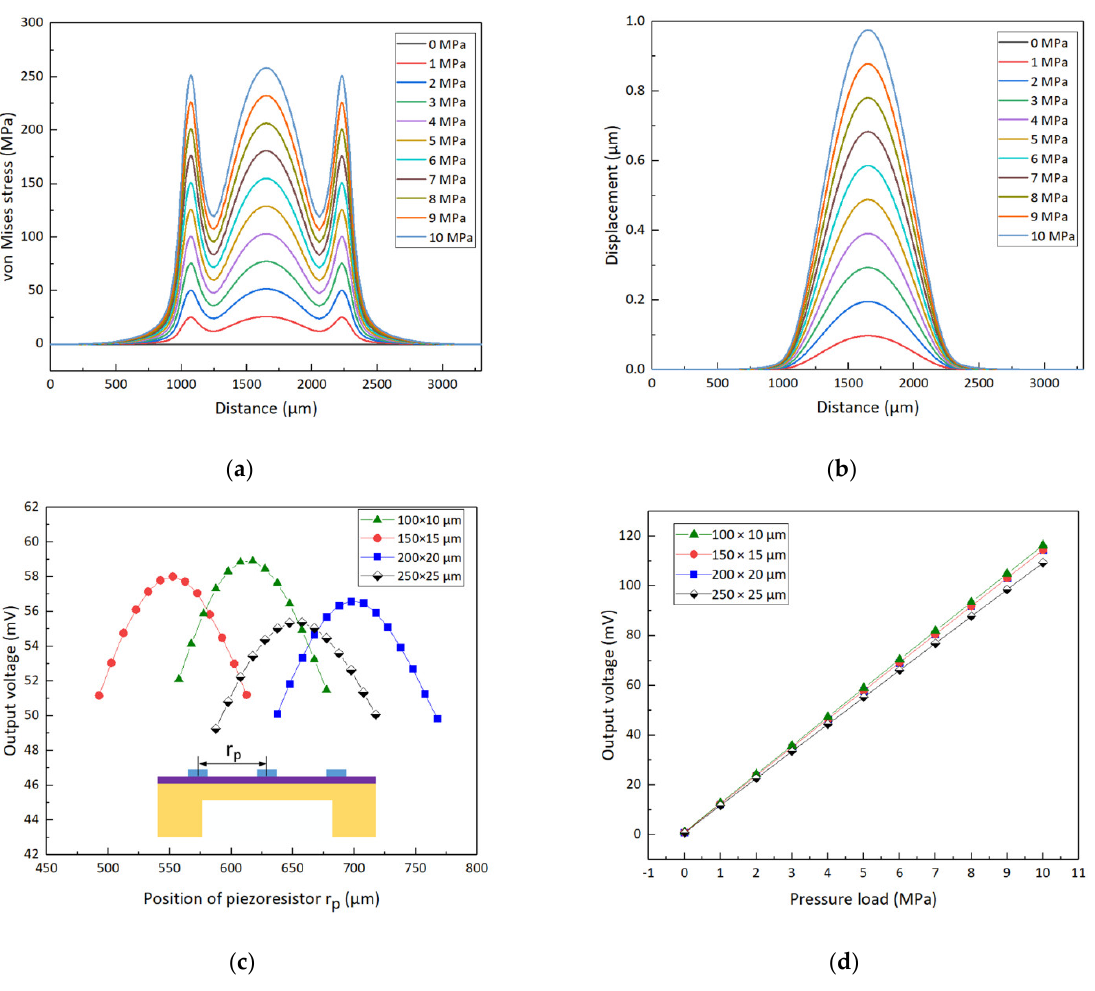
Figure 2. ( a ) The von Mises stress and ( b ) the displacement along the radial direction of the sensor chip diaphragm under different pressure loads. ( c ) The outputs of the four Wheatstone bridges with piezoresistor of different sizes vary with the distance between the folded piezoresistor and the center of the circular diaphragm. ( d ) The outputs of the Wheatstone bridge under 200% full-scale overload pressure.